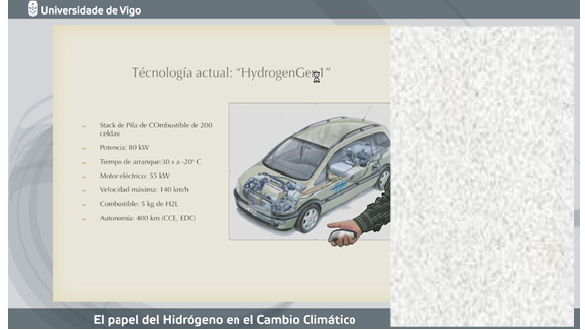
Figure 2. Snapshot of the knowledge pill